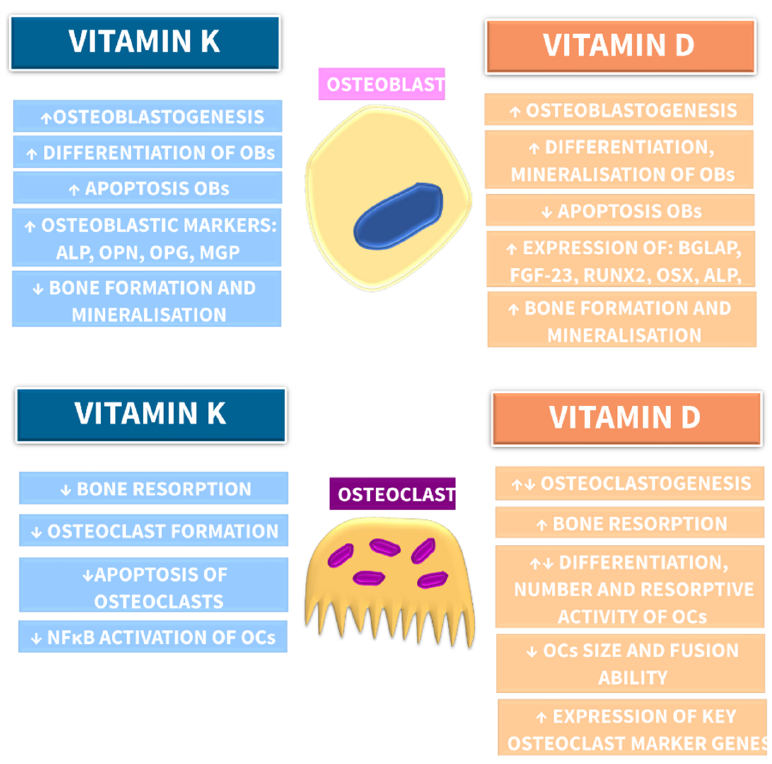
Figure 4. Impact of vitamin K and vitamin D on bone remodeling—evidence derived from in vitro studies. Abbreviations: OBs, osteoblasts; ALP, alkaline phosphatase; OPN, osteopontin; OPG, os- teoprotegerin; MGP, matrix Gla proteins; BGLAP, bone-Gla-protein; FGF-23, fibroblast growth